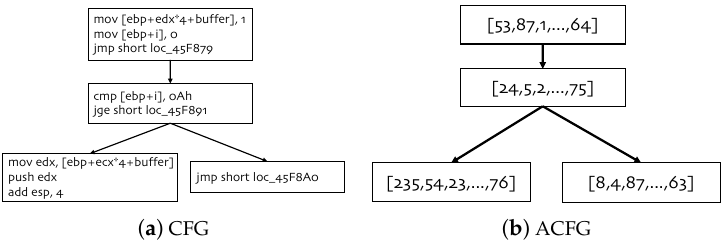
Figure 1. Two types of representation graphs for binary programs. CFG is the control flow graph for assembly functions. ACFG is the vectorization of CFG. Each basic block in ACFG corresponds to a feature vector of the CFG